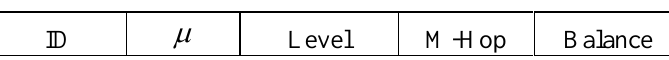
Figure 2. Packet structure of